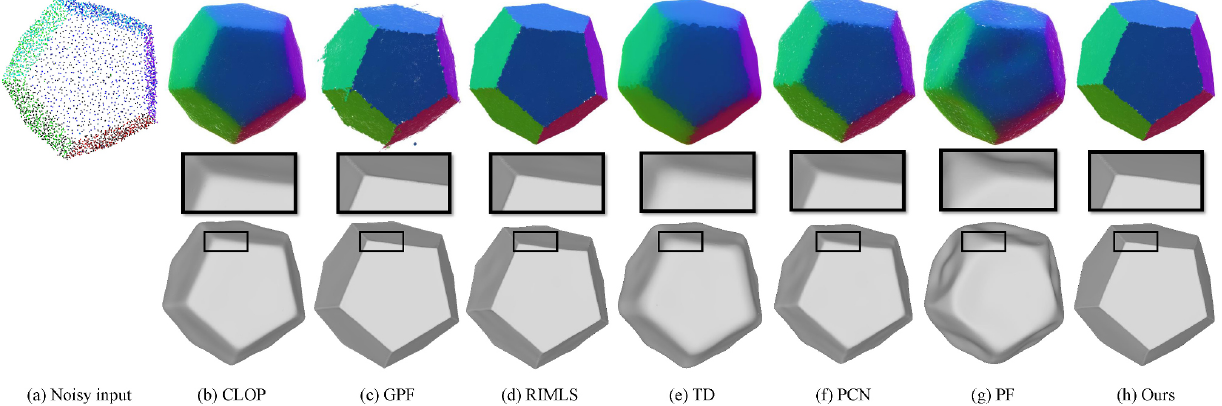
Fig. 7 Results on Dodecahedron corrupted with 0.5% synthetic noise. Above: corresponding upsampling results. Below: reconstructed meshes.